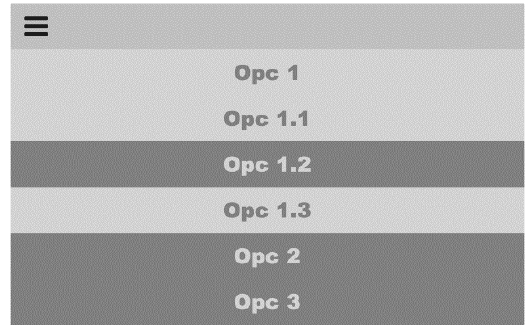
Figure 18. Visualization of the navigation menu with a screen width less or equal 800 pixels and the options